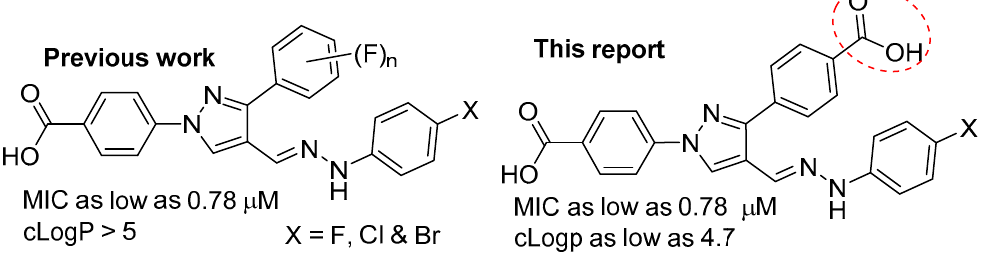
Figure 1. Pyrazole derived hydrazones as potent anti- Acinetobacter baumannii agents.